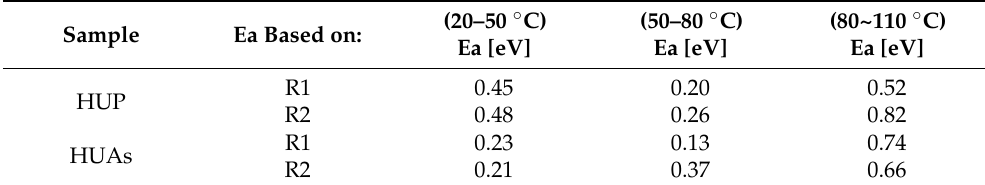
Table 2. Values of activation energies determined for HUP and HUAs milled-pelletized materials on the basis of three separated temperature ranges.